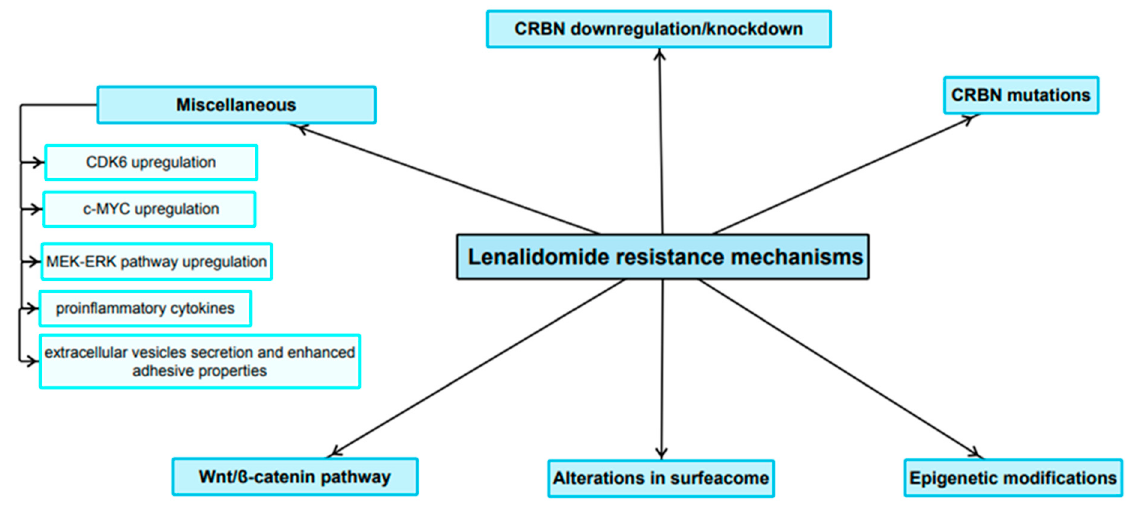
Figure 3. Main LEN-resistance